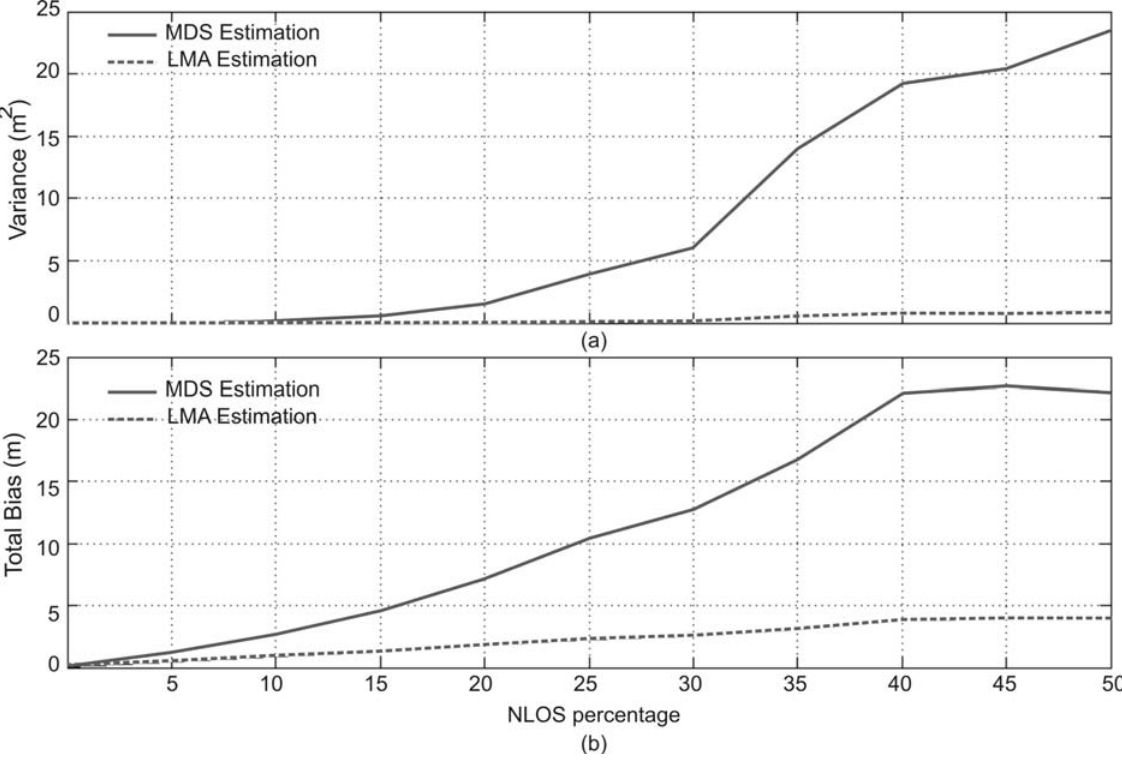
Figure 9. Errors in the position estimation considering NLOS effect between nodes N N (see the node distribution in Figure 5). (a) Total variance in the coordinate estimation. 14 (b) Total bias in the coordinate